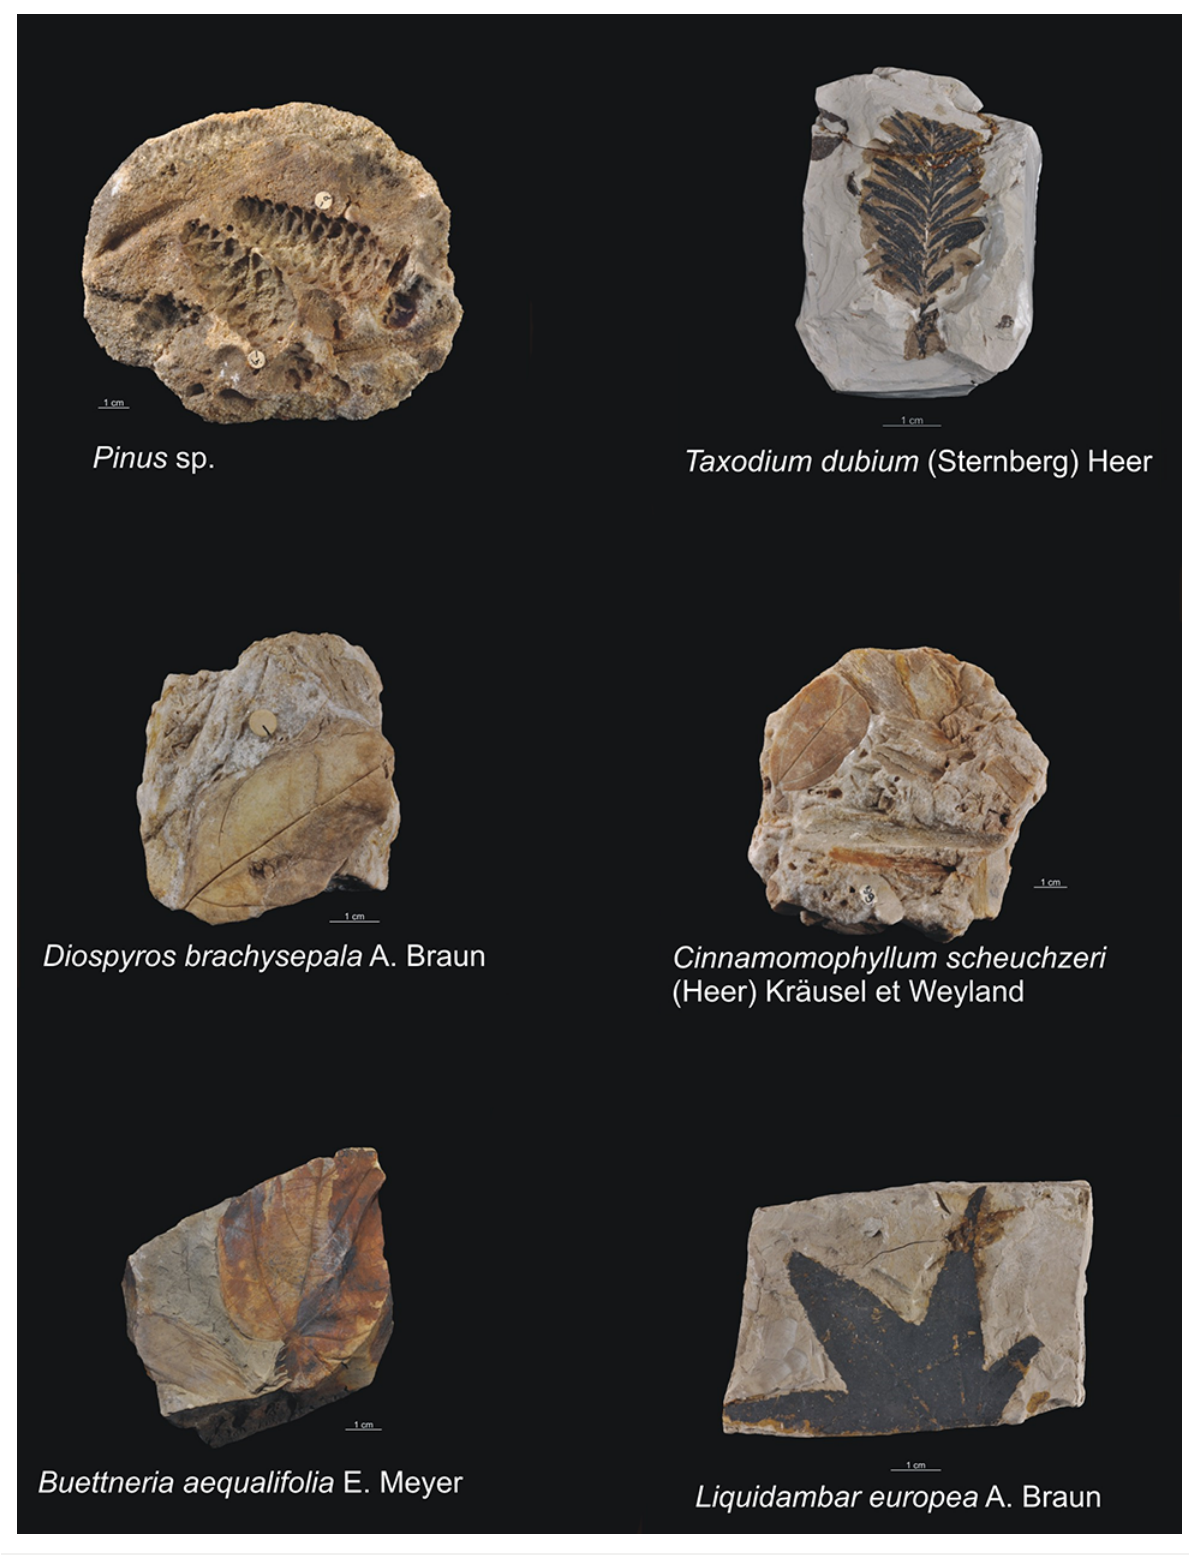
Figure 1 Miocene macroflora from the Polish Geological Institute Museum collection. Photo: K.